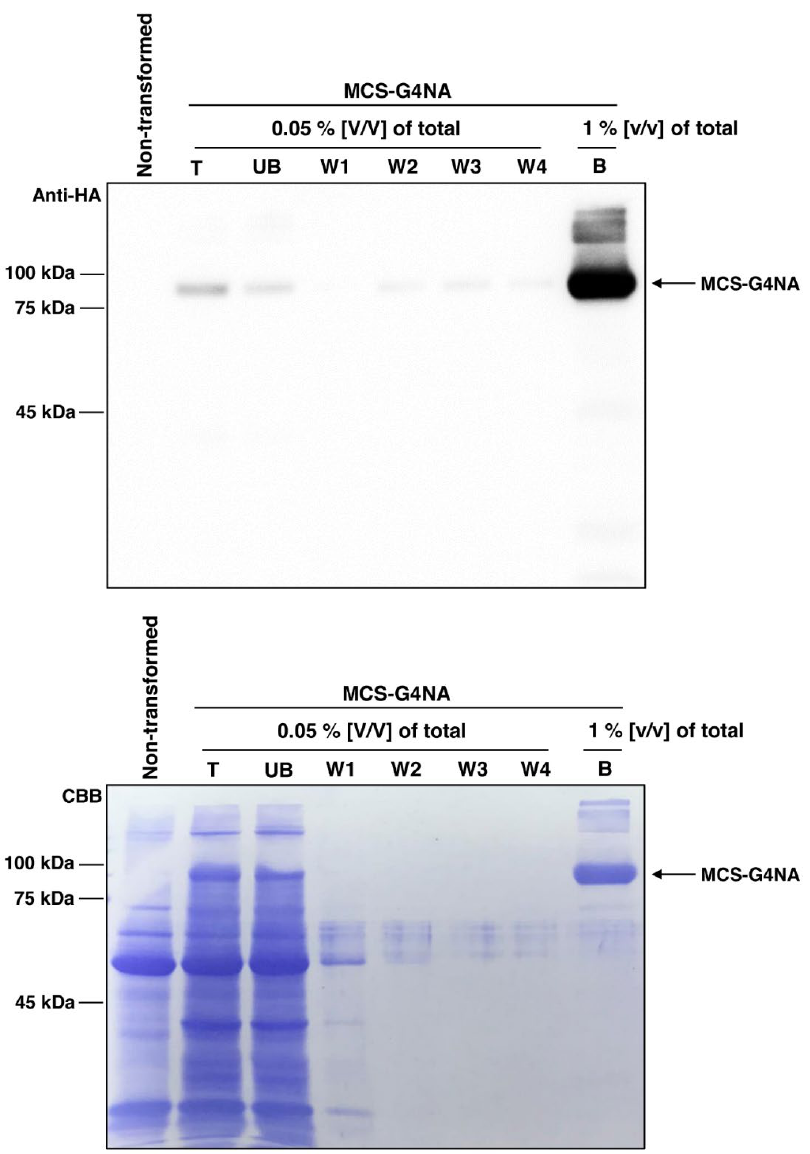
Figure 3. Purification of MSC-G4NA from the N. benthamiana leaf extracts. Total (T) protein extracts were centrifuged and the soluble protein fraction from the supernatant was incubated with MCC beads to purify MCS-G4NA. After centrifugation, the supernatant fraction was collected as the unbound (UB) fraction. Subsequently, the MCC beads were washed four times with a wash buffer (50 mM Tris-HCl and 150 mM NaCl; pH 7.5) (W1–W3). Finally, MCS-G4NA was eluted by boiling with a protein sample buffer. T, total protein extracts; UB, unbound fraction; and B, MCC bead-bound fraction. After Western blotting, the membrane was stained with Coomassie Brilliant Blue